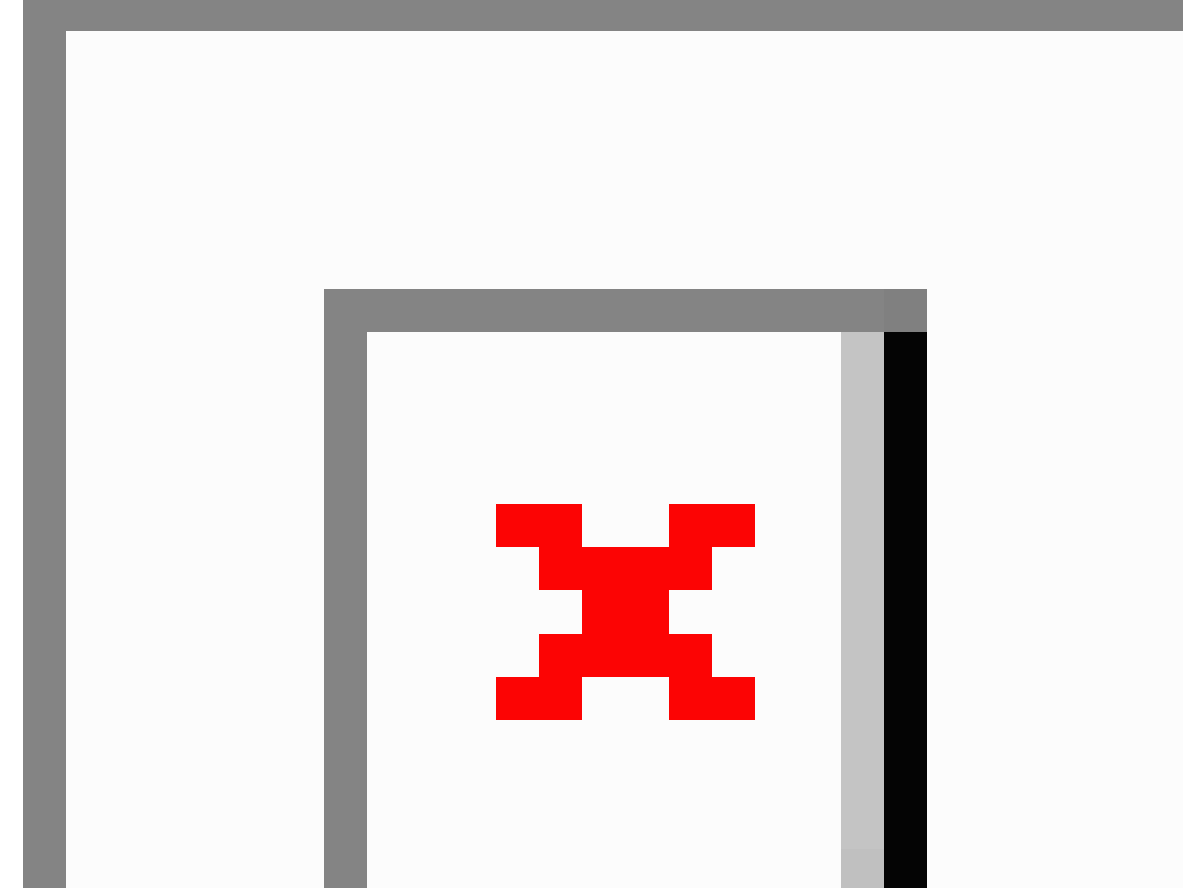
Figure 1. World map showing the distribution of short message service (SMS) intervention studies in developing countries (number of studies per